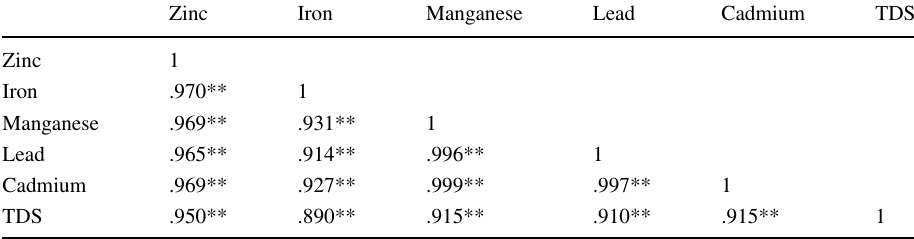
Table 6 Correlation coefficient matrix of analyzed heavy metals and TDS of groundwater